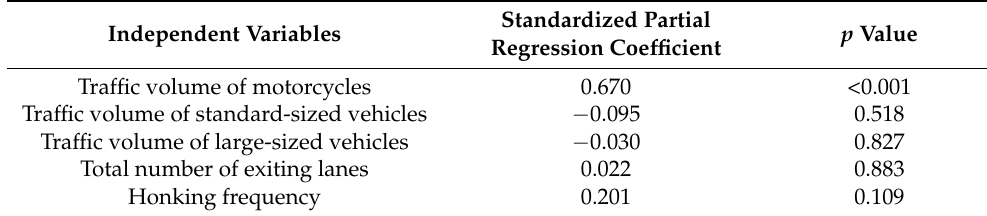
Table 10. Result of multiple regression analysis for L Aeq,10min .